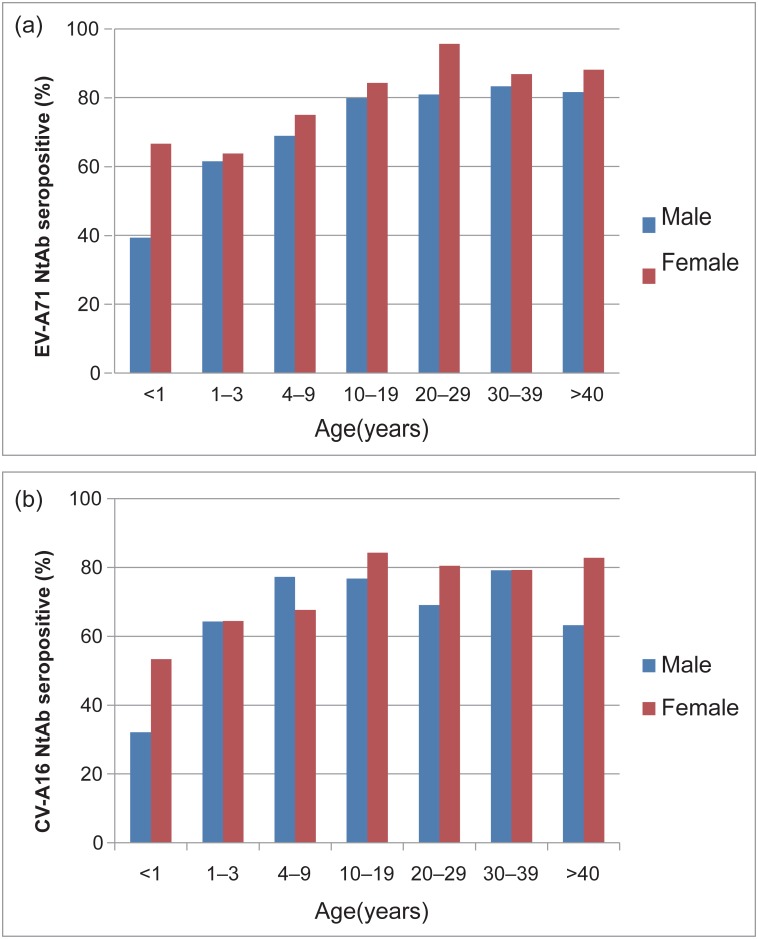
Age-rated and sex-dependent prevalence of neurtralizing antibodies to EV-A71 (upper panel) and CV-A16 (lower panel) in healthy individuals in Shandong province.(Male, blue bars; female, red bars).